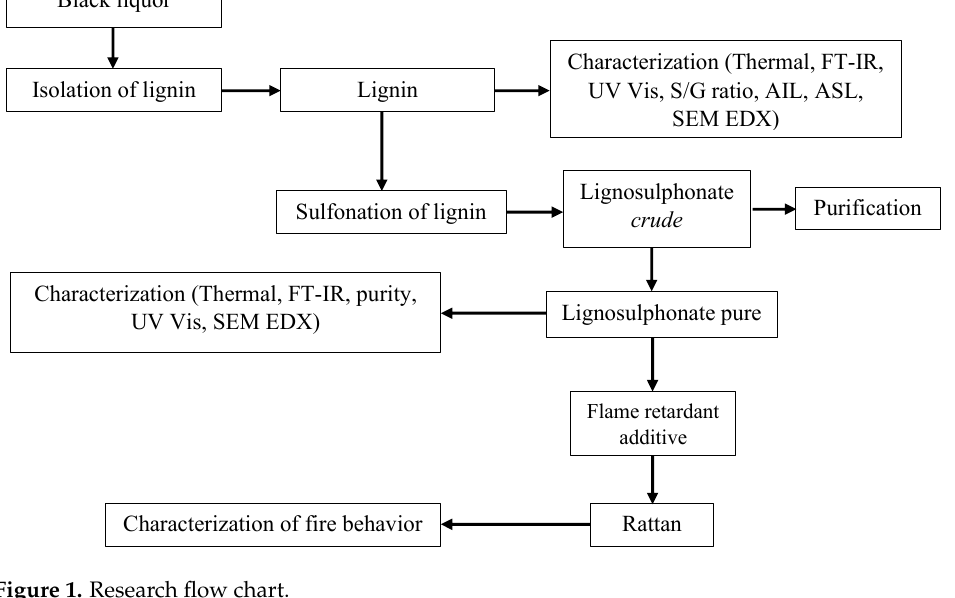
Figure 1. Research flow chart.